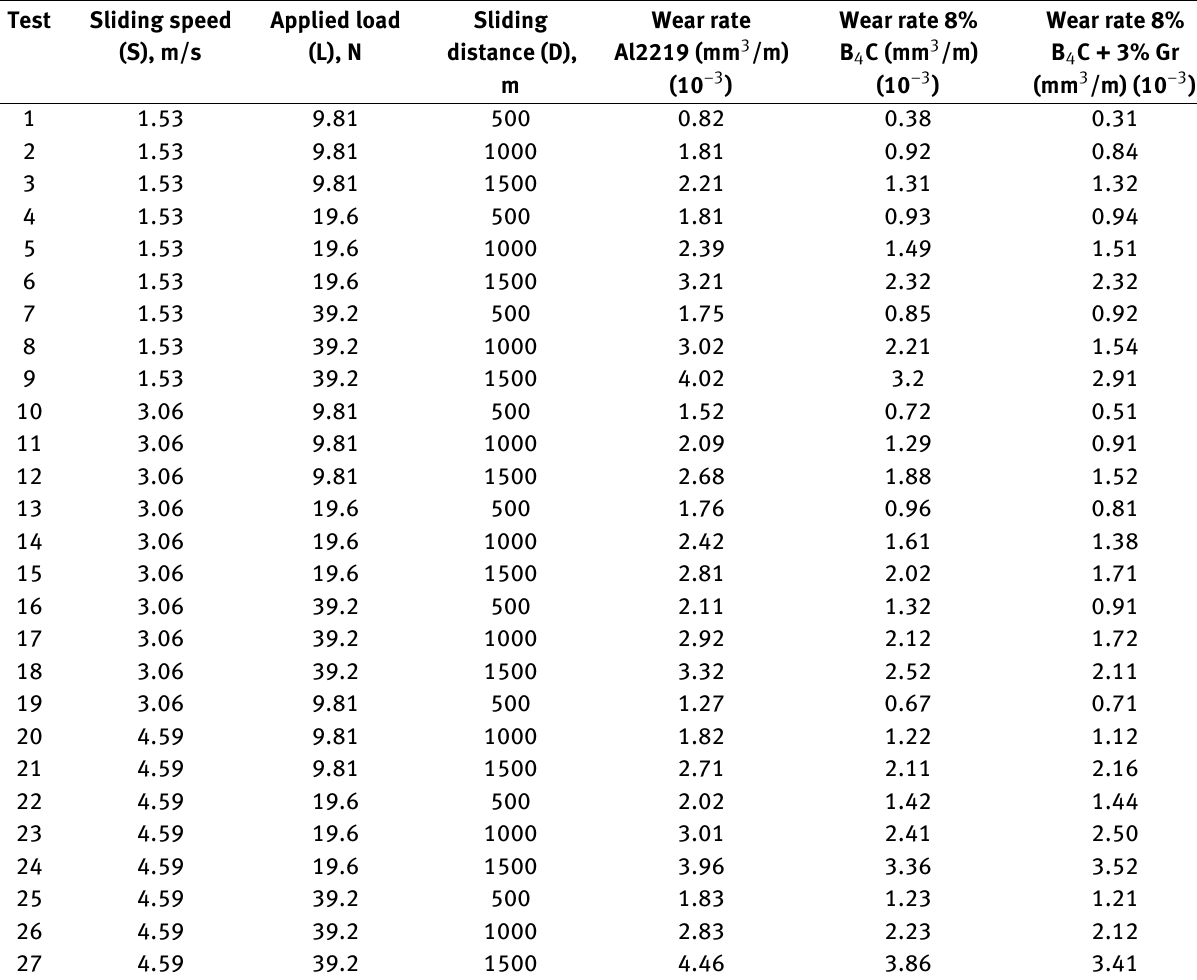
Table 3: Orthogonal array of Taguchi wear test results